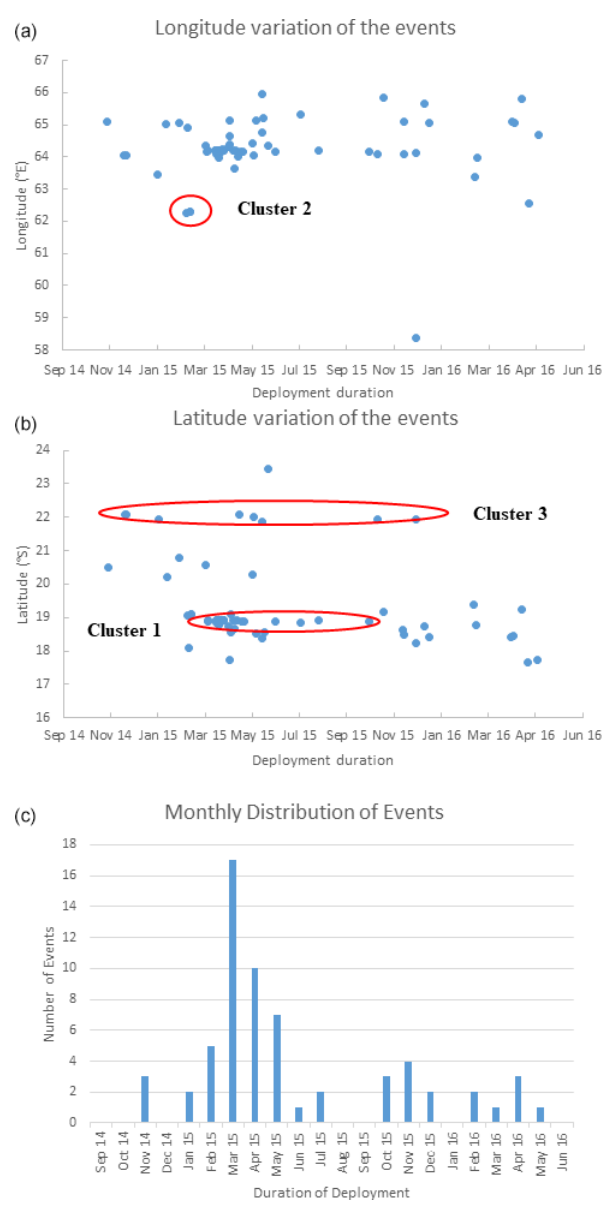
Figure 10. Variation in longitude (a) and latitude (b) of the events detected and located using Rodrigues array. Monthly distribution of the events is shown in (c) . The solid red line in (b) marks the events for Cluster 1 ( ∼ 120km northeast of Rodrigues Island), Cluster 2 ( ∼ 140km northwest of Rodrigues Island), and Cluster 3 ( ∼ 265km south of Rodrigues